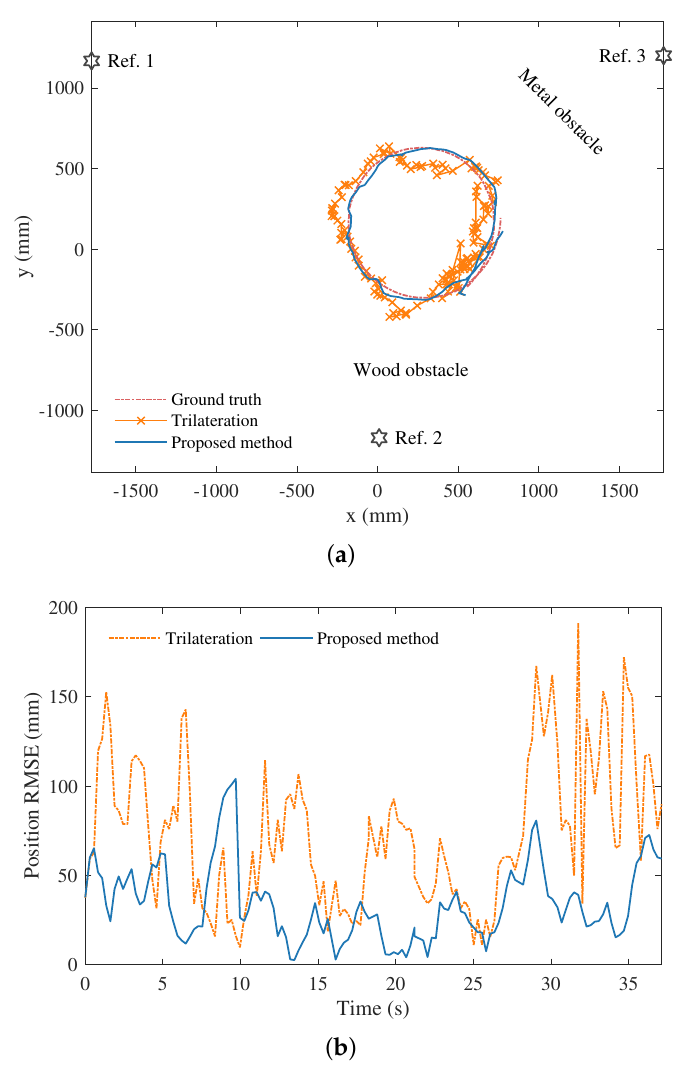
Figure 7. Experiment results in mobile target tracking. ( a ) depicts the three UWB reference points deployed in the experiment. In addition, the estimated trajectory of the mobile robot using the proposed method, trajectory based on trilateration of raw range measurements, and their ground truth are shown in ( a ). The comparison of the position root mean squared errors (RMSEs) of using the proposed approach and the trilateration is presented in ( b